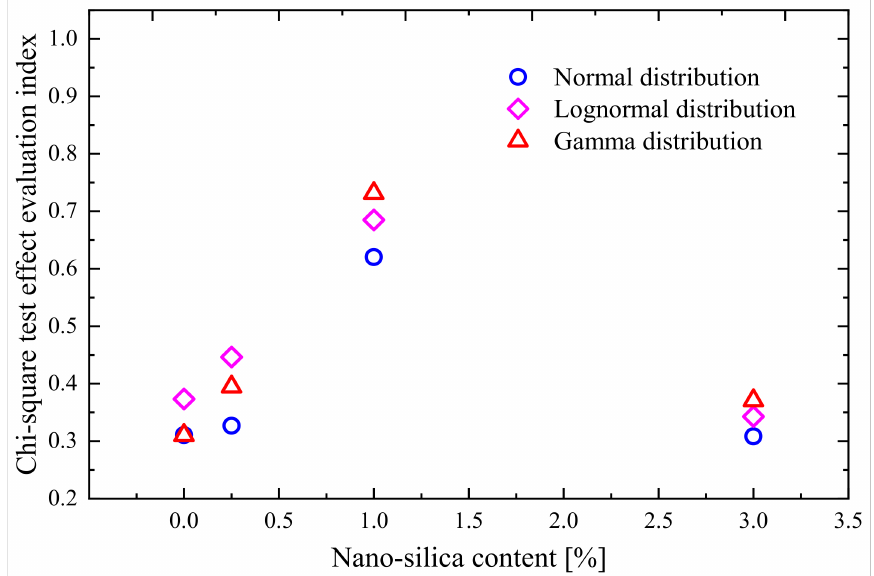
Figure 13. CEI results of the normal, lognormal, and Gamma distributions of the average V D < 0.1 µ m